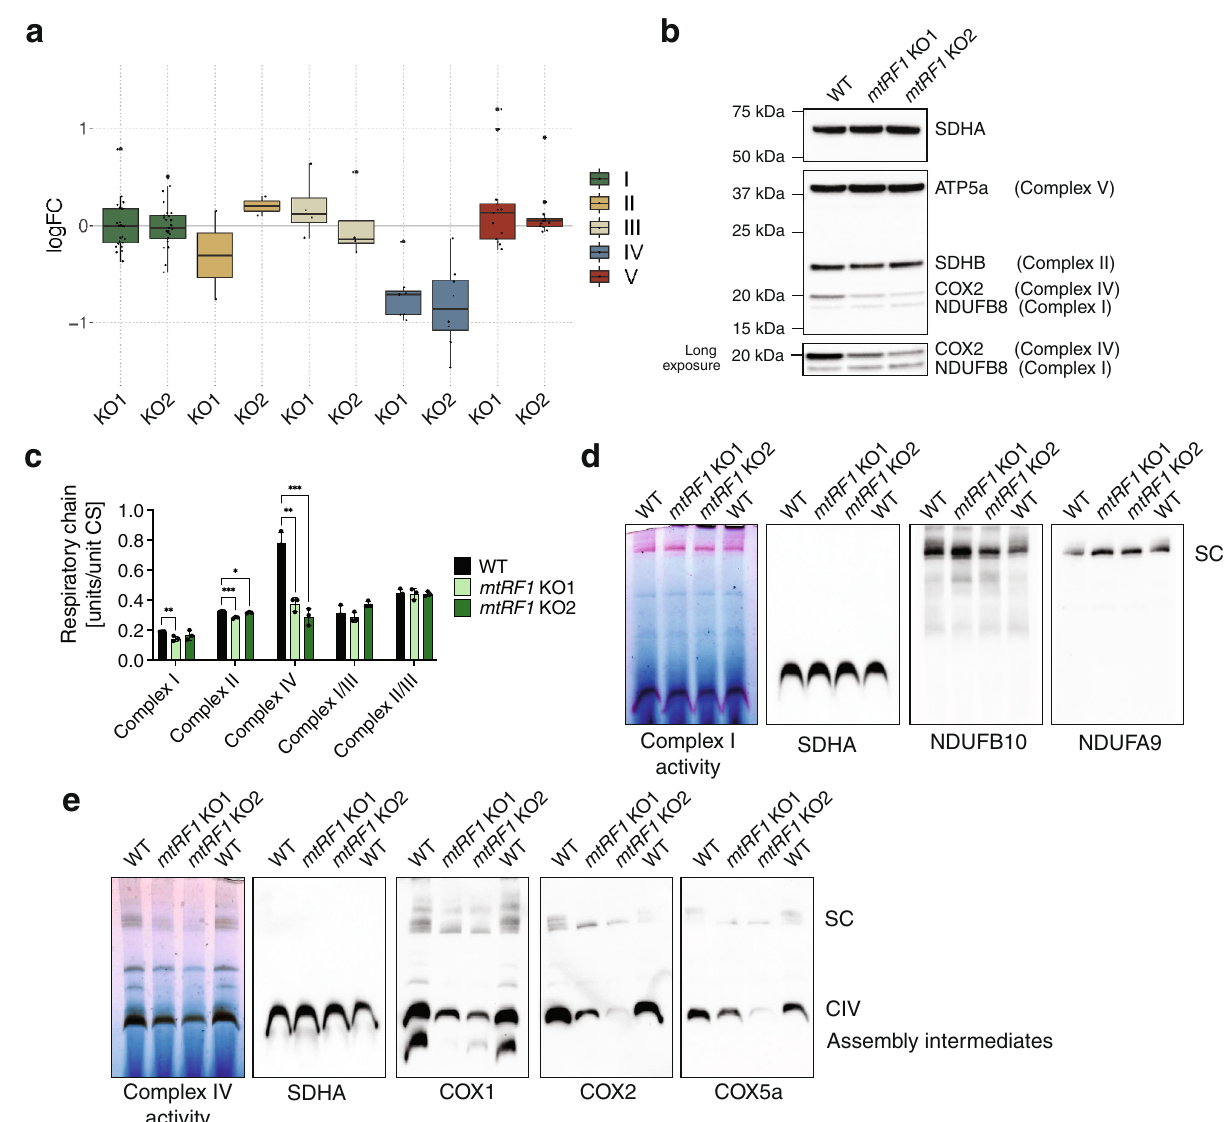
Fig. 3 | mtRF1 KO cells exhibit complex IV defect. a Quantitative mass- spectrometry analysis of OXPHOS complex proteins from HEK mtRF1 KO cells compared to HEK WT cells. Due to the high hydrophobicity of OXPHOS complex proteins, only a subfraction could be detected in the mass-spectrometer and ana- lyzed. Log2(fold change) (logFC) of mtRF1 KO1 and mtRF1 KO2 vs. WT samples is plotted (values are listed in Supplementary Table 4). Each dot represents one proteinfromtheOXPHOScomplexes.Peptideswereproducedfrommitochondrial lysates. n =3 independent experiments. Summary of boxplots is depicted in Sup- plementary Fig. 5a. b OXPHOS protein levels analyzed by western blotting. Mito- chondriallysateswereloaded.MembraneswereprobedwiththeOXPHOSantibody